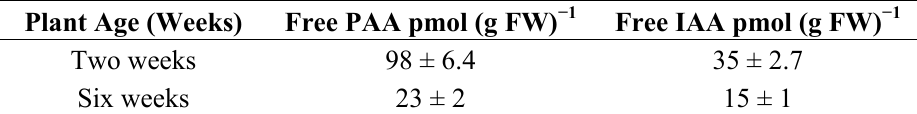
Table 2. PAA contents in two-week old and six-week old leaf tissue of A. thaliana a . Plant Age